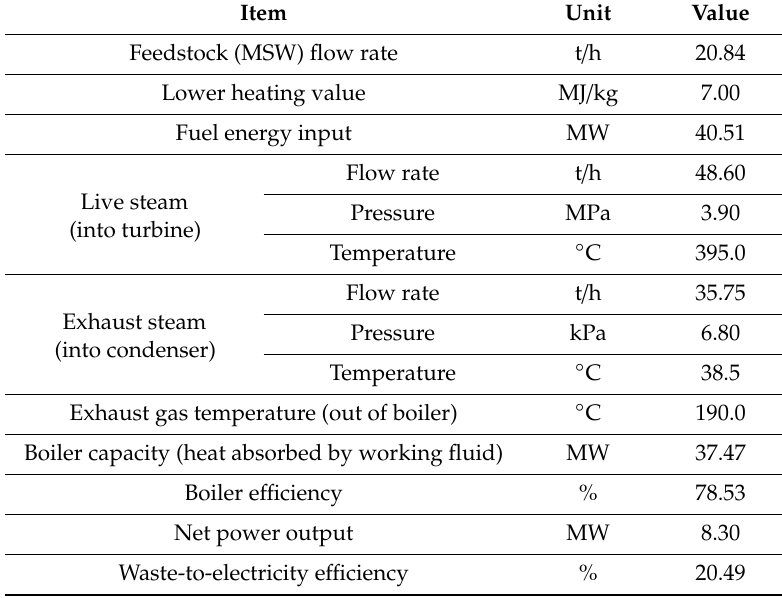
Figure 1. Reference WtE plant. Table 1. Basic parameters of the reference waste-to-energy (WtE) plant. MSW: municipal solid